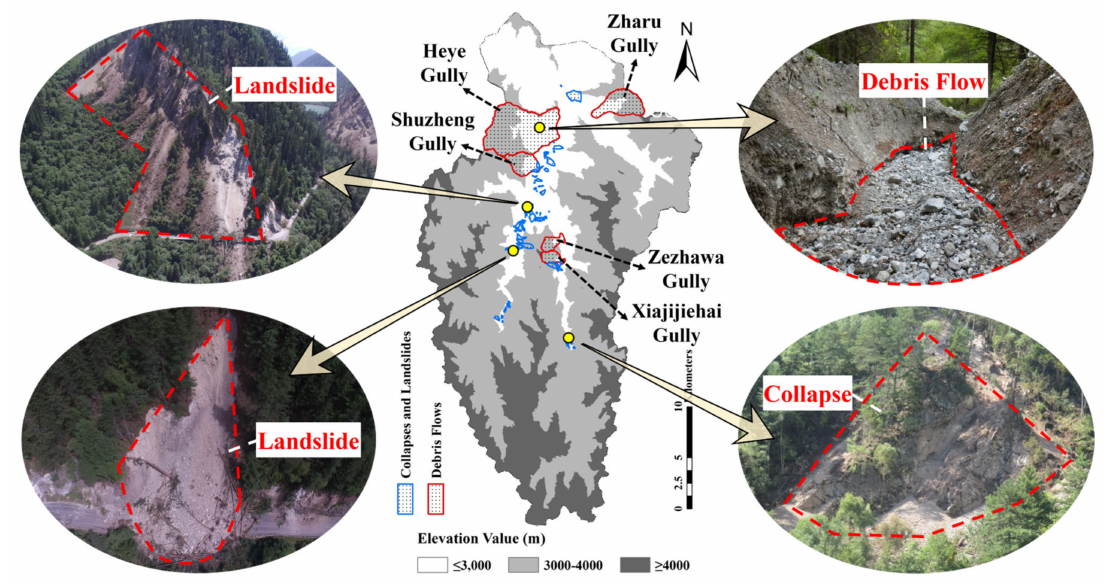
Figure 7. The areas affected by geohazards, including landslides, debris flows and collapses and the scenes of typical earthquake-induced geohazards in Jiuzhaigou